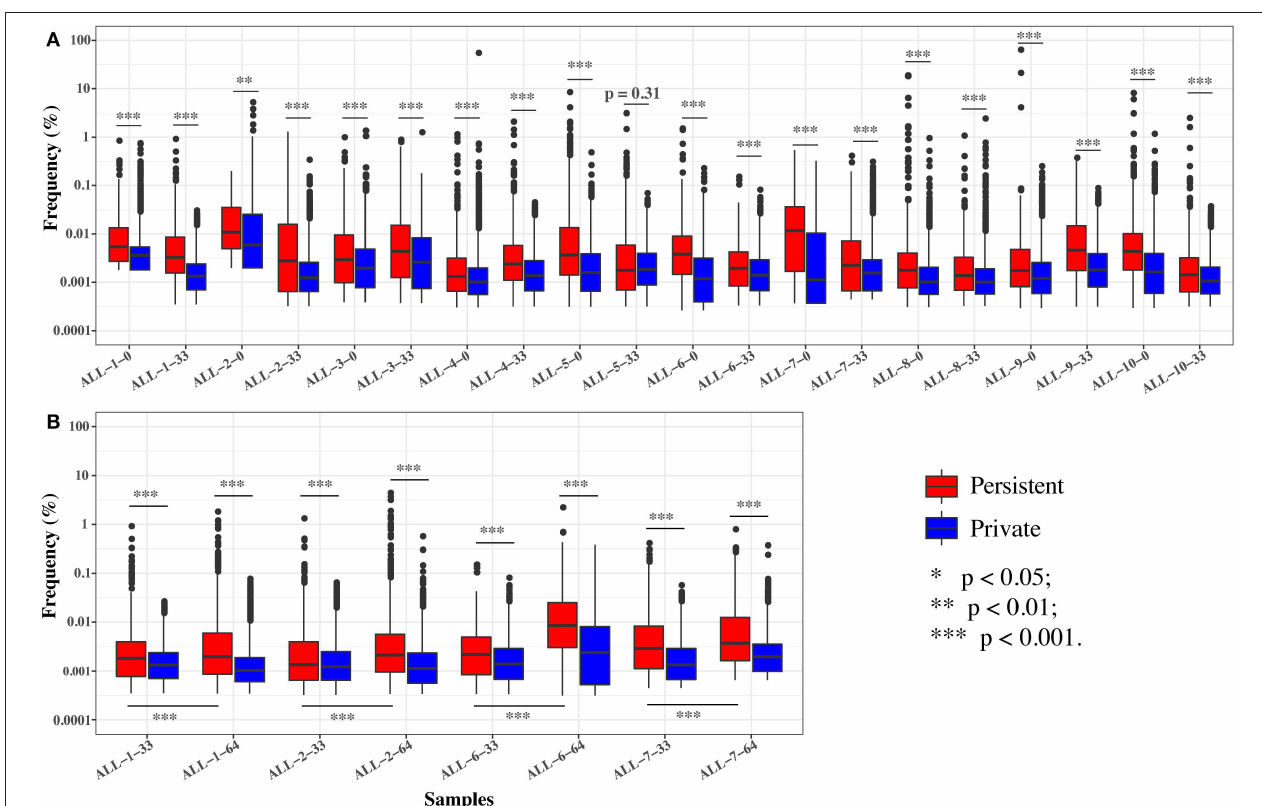
FIGURE 5 | The frequencies of the persistent and private clonotypes on two time points. (A) On days 0 and 33. (B) On days 33 and 64. ALL-1-0, ALL-1-33, and ALL-1-64 refer to frequencies on days 0, 33, and 64, respectively. Paired tests were performed on the frequencies of persistent clonotypes between day 33 and 64.